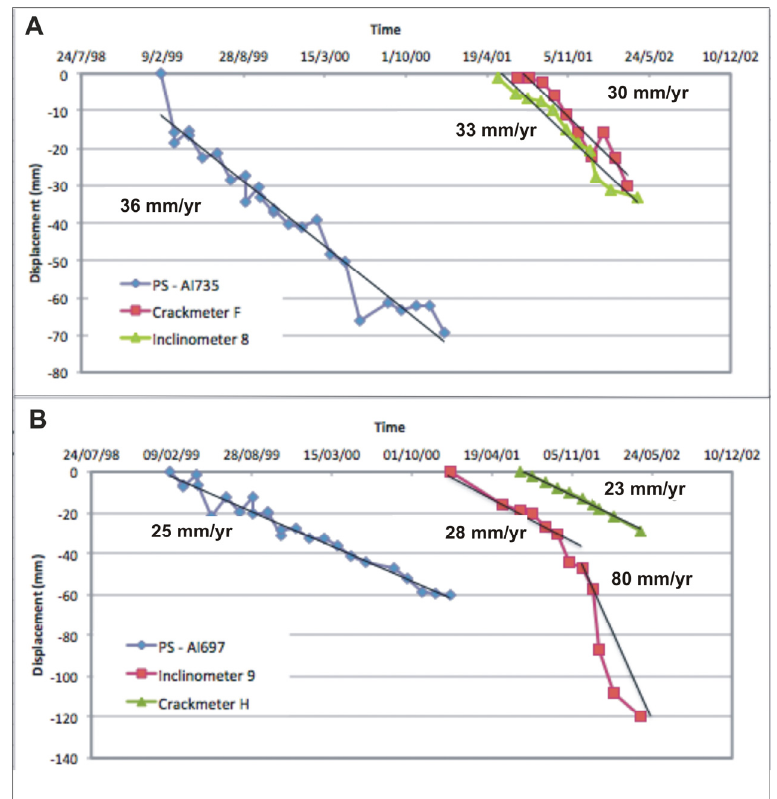
Figure 6. Quantitative comparison among time series of two radar benchmarks (( A ) AI735 and ( B ) AI697), inclinometers and crackmeters. The location of the instruments is reported in Figure